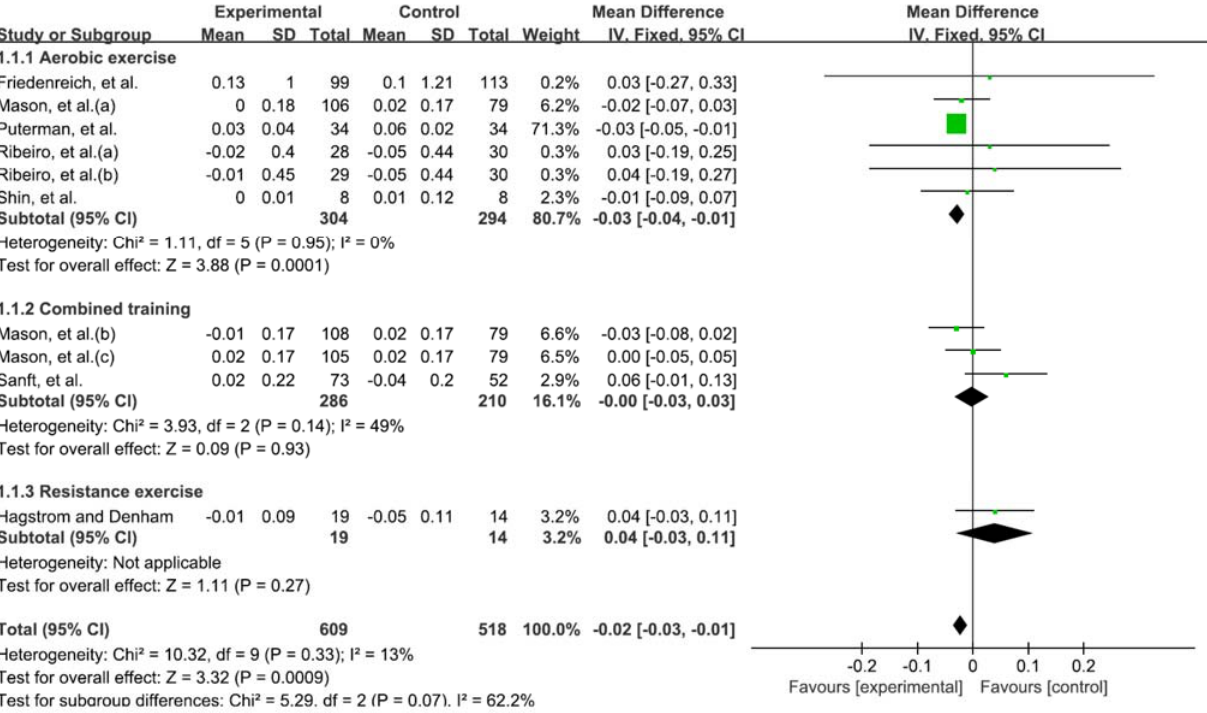
Figure 3. Forest plot on the effect of exercise on telomere length. Mason et al. (a) aerobic exercise; (b) aerobic exercise and combinded training; (c) combinded training. Ribeiro et al. (a) continuous aerobic training; (b) intermittent aerobic training.